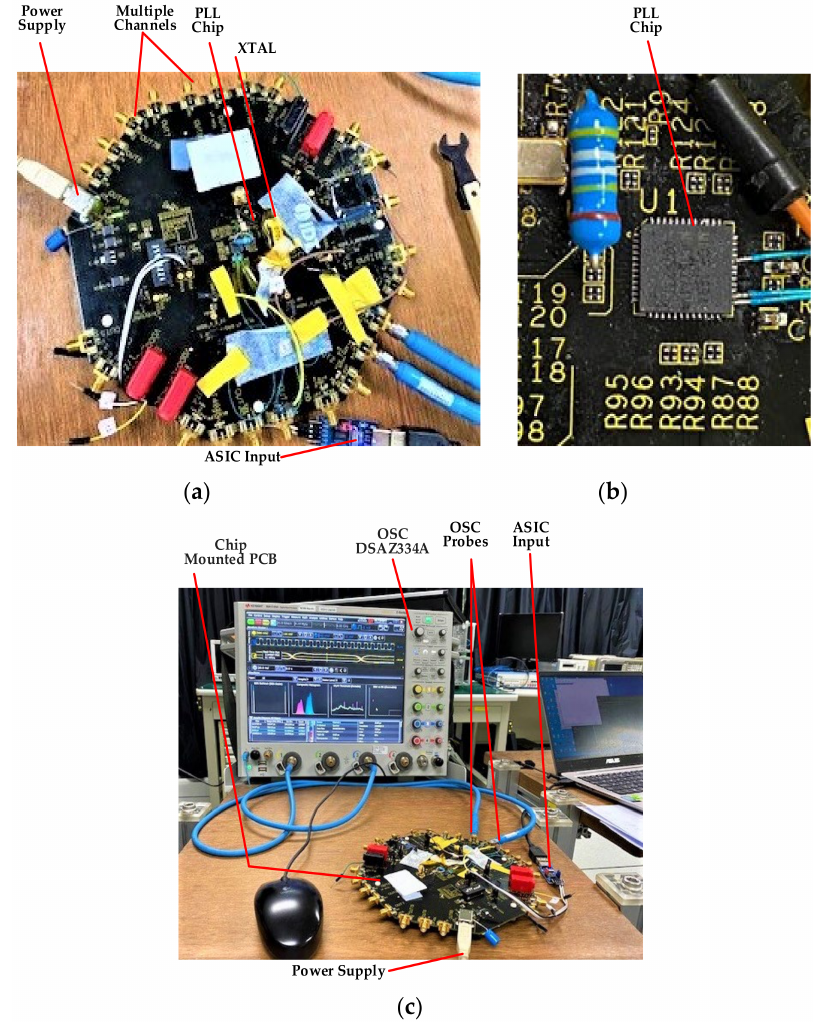
Figure 19. ( a ) PLL chip mounted on PCB; ( b ) PLL chip; ( c ) PLL measurement